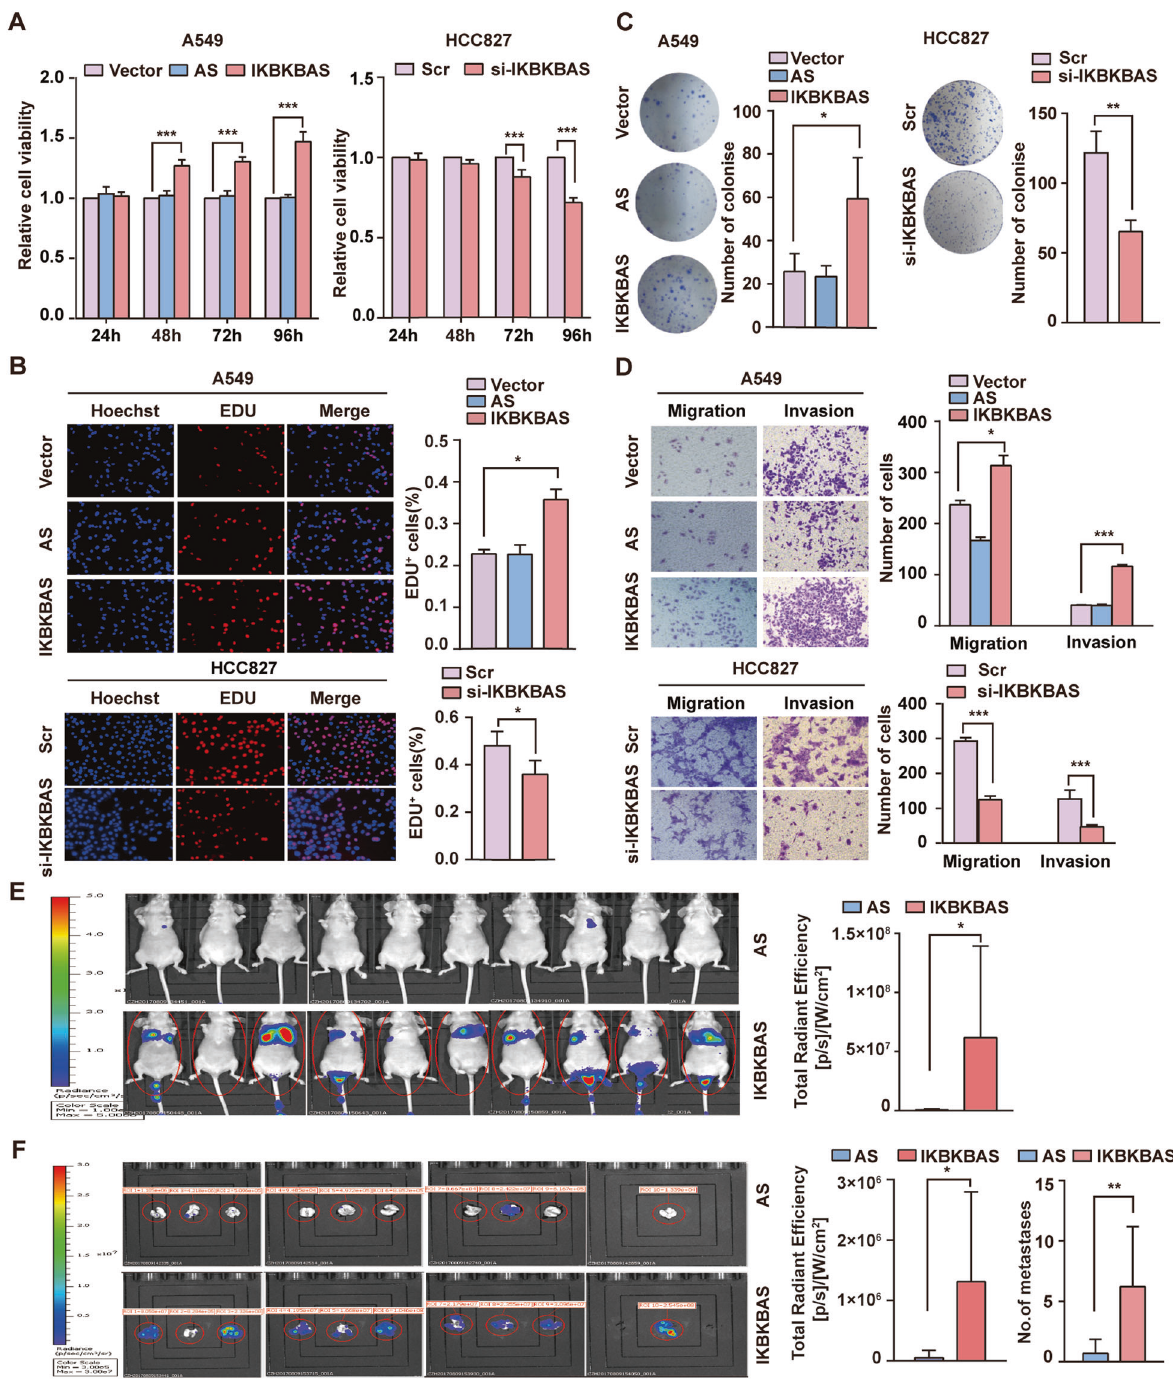
Fig. 2 IKBKBAS promoted LUAD cells proliferation and metastasis in vitro and in vivo. Overexpression of ectopic IKBKBAS in A549 cells and knockdown of IKBKBAS in HCC827 cells were carried out for MTT assays ( A ), EdU assays ( B ), plate colony formation assays ( C ), transwell assays ( D ). A , B The effect of IKBKBAS on LUAD cell proliferation was evaluated by MTT assays and EdU assays. C The effect of IKBKBAS on colonizing ability was determined by plate colony formation assays. D The effect of IKBKBAS on invasion and migration ability was evaluated by transwell assays. E Luminal imaging of tumors in nude mice at 44 day following tail vein injection of IKBKBAS/IKBKBAS-AS and luciferase-expressing A549 cells were detected via a novel in vivo imaging system following luciferin injection. The red circle indicated the photon intensity in the mouse (×10 6 , mean ± SD, n = 10). F Luminal imaging for lung metastasis of A549 xenografts stably expressing IKBKBAS or IKBKBAS-AS. The red circle indicates the photon intensity in the mouse (×10 6 , mean ± SD, n = 10). Data show mean ± SD, n ≥ 3, * P < 0.05, ** P < 0.01, *** P < 0.001.